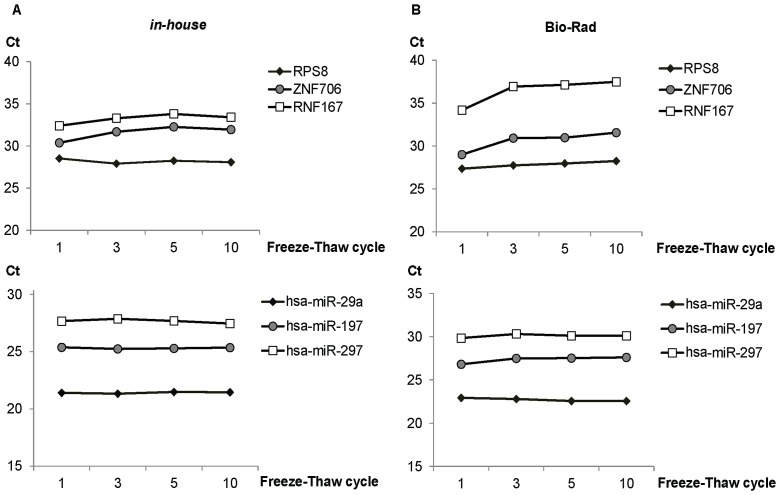
Remarkable stability of mRNA and miRNA at repeated freeze-thaw cycles in the in-house lysates.M14 cultured in 96-wells at 104 cells per well (biological triplicates) were directly lysed by (A) in-house or (B) Bio-Rad lysis buffers. Cell lysates were collected and aliquoted. The lysates were then frozen at −70°C, thawed in a temperature-controlled water bath at 25°C, and the freeze-thaw cycles repeated. The miRNA and mRNA expressions were quantified following 1, 3, 5, 10 freeze-thaw cycles. The qPCR assays from set 2 were used for quantifications. Ct was plotted against freeze-thaw cycles to examine the stability of RNA. The experiments were conducted in biological duplicates.